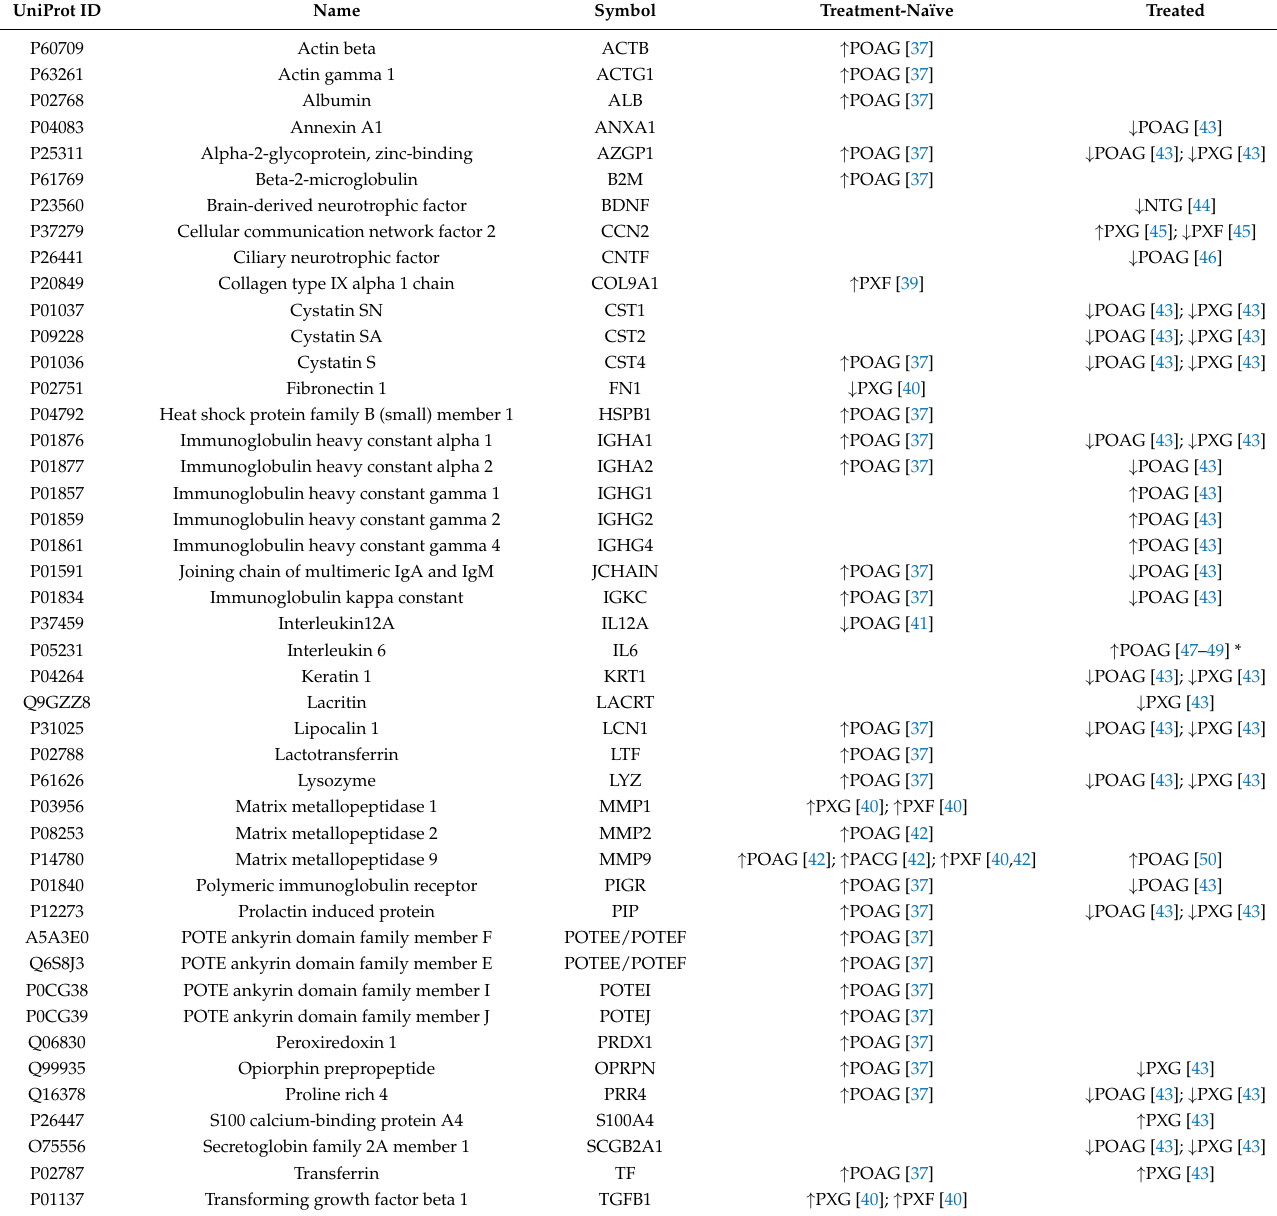
Table 1. The glaucoma effects on tear proteins according to previous